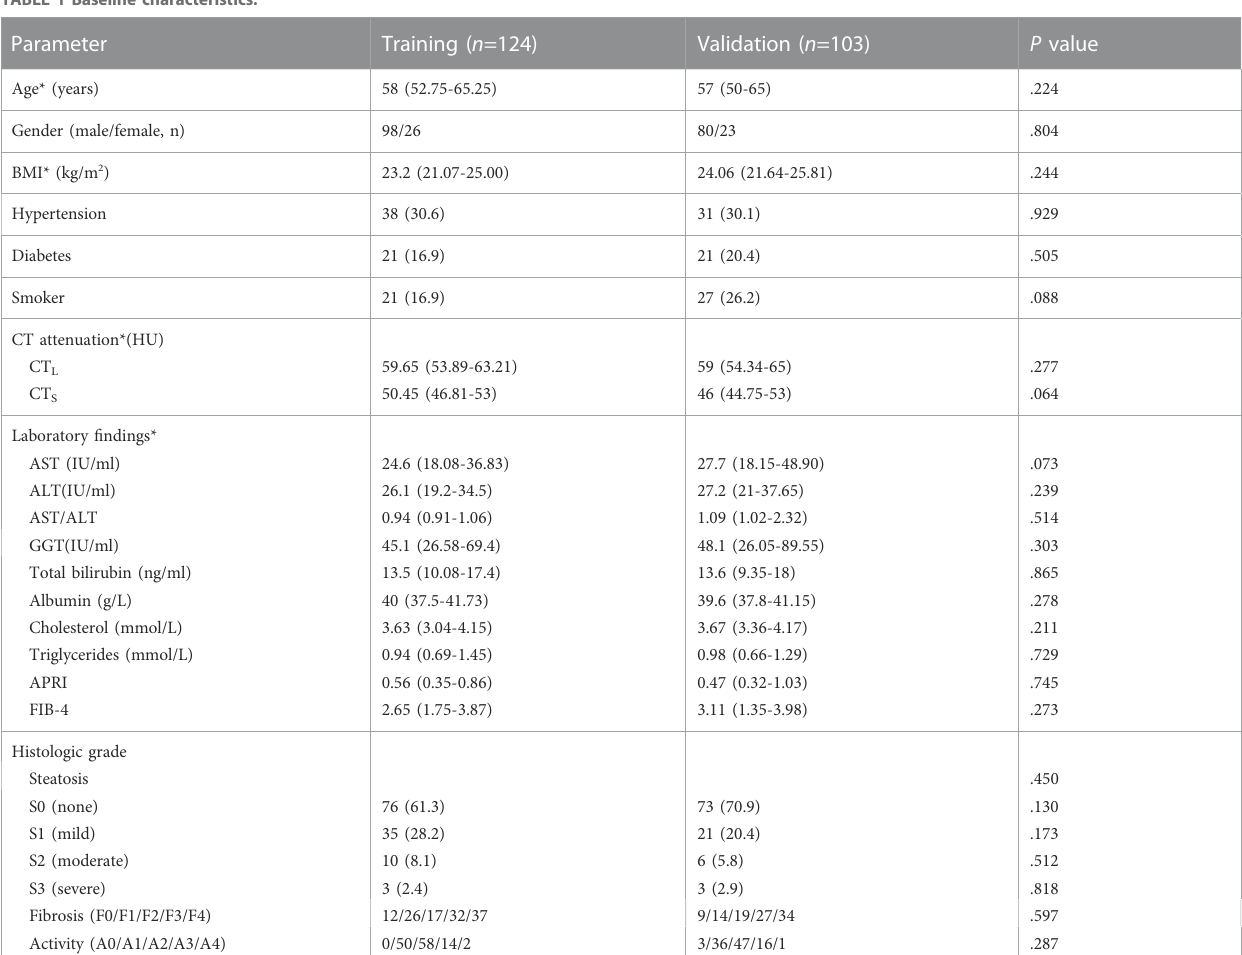
TABLE 1 Baseline